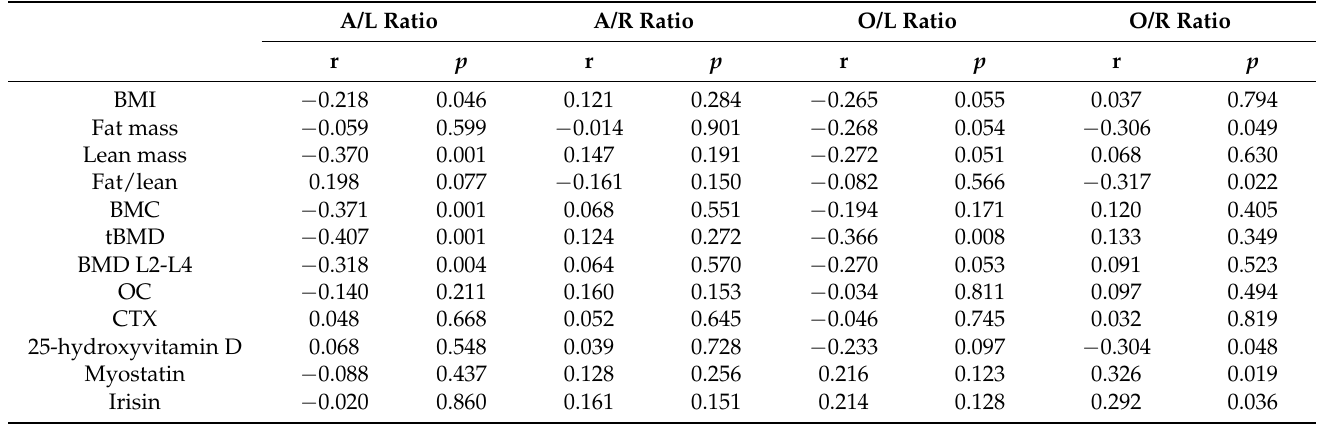
Table 5. Correlation analysis between ratios of anti- to pro-inflammatory adipokines and anthropometric parameters, bone markers and myokines in the whole group of studied children ( n =